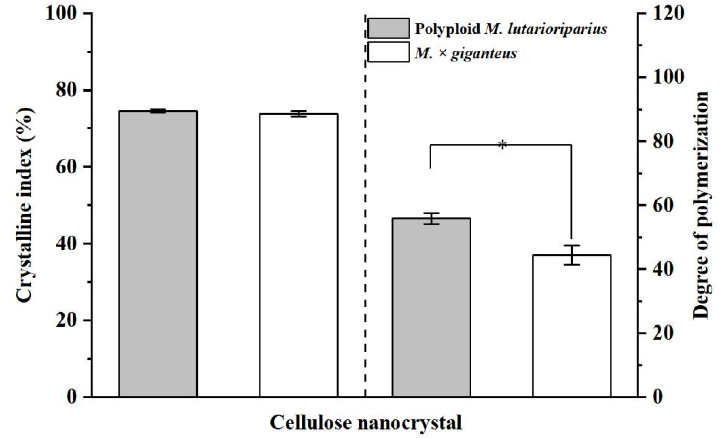
Figure 7. Crystalline index and degree of polymerization of CNC in polyploid Miscanthus lutarioriparius and Miscanthus × giganteus .* Significant difference at p ≤ 0.05. Vertical bar are standard deviation ( n = 3).